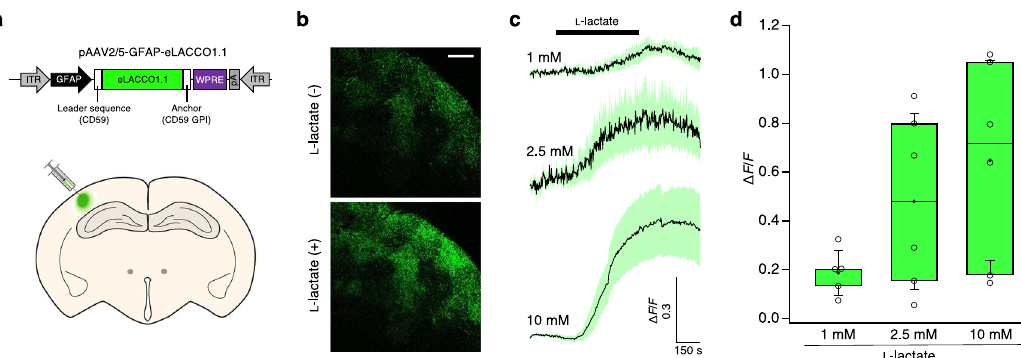
Fig. 5 Two-photon imaging of L -lactate on astrocytes in acute brain slices. a Schematic illustration of AAV injection into the somatosensory cortex for the brain slice experiments. ITR inverted terminal repeat, GFAP human glial fi brillary acidic protein promoter, WPRE woodchuck hepatitis virus posttranslational regulatory element, pA human growth hormone polyA signal. b Representative two-photon images of eLACCO1.1 expressed on astrocytes in brain slice before and after 10 mM L -lactate stimulation. Parallel experiments with deLACCO produced baseline fl uorescence that was not signi fi cantly higher than background and did not produce a signi fi cant change in fl uorescence relative to baseline ( Δ F / F = 0.85 ± 1.6, P = 0.25, two-tailed paired t -test). Similar results were observed from more than 3 slices. Scale bar represents 50 μ m. c Fluorescence traces of eLACCO1.1-expressing astrocytes in response to bath application of L -lactate (mean± s.e.m.). 1 mM L -lactate ( n = 5 slices from 4 mice), 2.5 mM L -lactate ( n = 5 slices from 4 mice), or 10 mM L -lactate ( n = 6 slices from 4 mice). d Δ F / F plots for eLACCO1.1 at each dose of L -lactate. Δ F / F was calculated by: Δ F / F = (( F x − F b )/ F b ), where F x is the peak fl uorescence intensity and F fl uorescence intensity. 1 mM L -lactate ( n = 5 slices from 4 mice, P = 0.01, two-tailed paired t -test), 2.5 mM L - b is the baseline lactate ( n = 6 slices from 4 mice, P = 0.02, two-tailed paired t -test), or 10 mM L -lactate ( n = 6 slices from 4 mice, P = 0.01, two-tailed paired t -test). The horizontal line is the median; the top and bottom horizontal lines are the 25th and 75th percentiles for the data; and the whiskers extend one standard deviation range from the mean represented as black fi lled circle. One slice data in the 2.5 mM group was omitted from the trace in c because it was not a complete time course, but Δ F / F of the slice could be measured and was included in d . Source data of c , d are provided as a Source Data fi le.